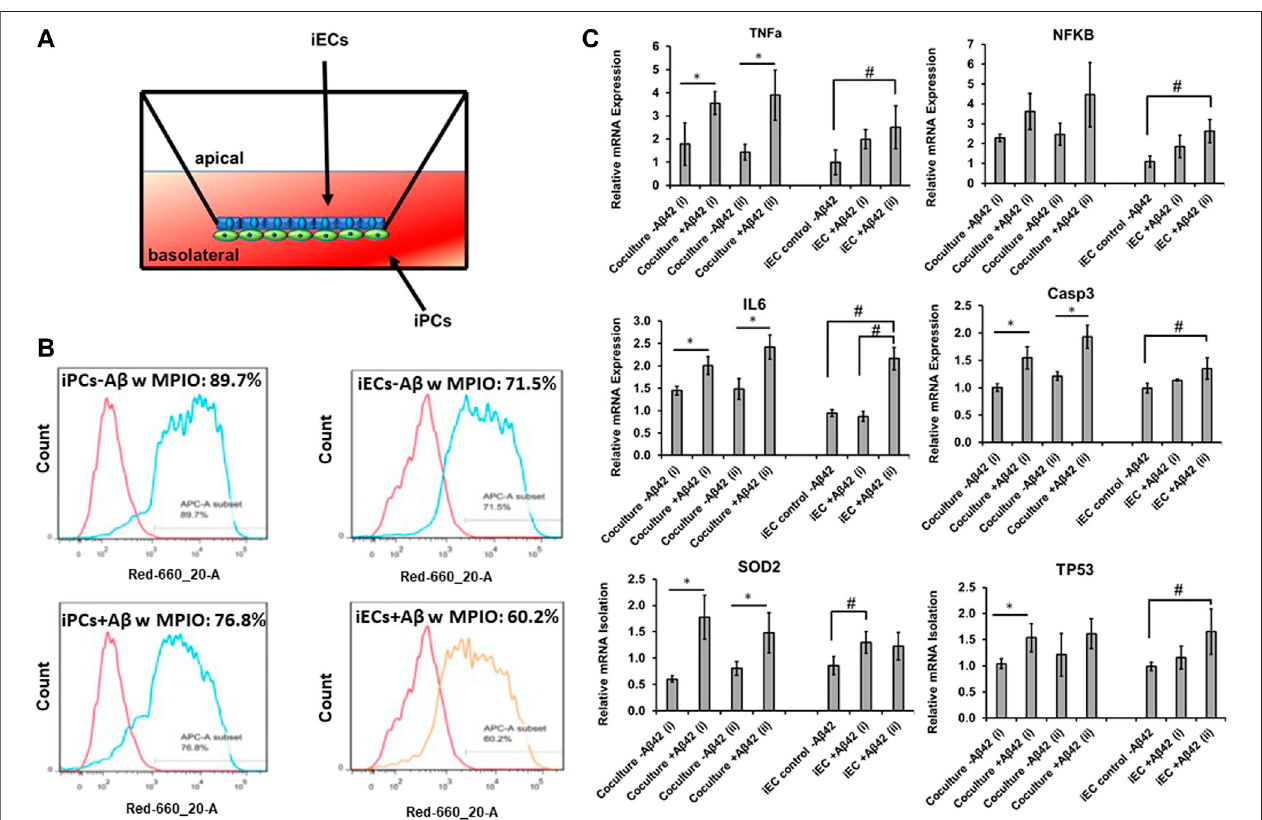
FIGURE 5 | mRNA levels of in fl ammatory response genes for A β 42 treated co-culture. (A) Illustration of the transwell of iEC and iPC co-culture. (B) Phagocytosis ability of the replated iPCs (day 25) and iECs determined by fl ow cytometry. The replated cells with or without A β 42 oligomer treatment (48 h) were exposed to MPIO at 5 μ gFe/mLfor24 h.TheMPIO+cells(Alexa647)wasquanti fi edby fl owcytometry.Tostudythein fl ammatoryresponse,thederivedendothelialcells(iECs)weretreated with A β 42 oligomers and compared to those without A β 42 treatment along with the transwell co-culture of iECs and iPCs with or without A β 42 oligomers. (C) RelativemRNAexpressionof TNFa , NFKB , IL6 , Casp3 , SOD2 ,and TP53 .ThemRNAexpressionwasnormalizedtotheA β 42negativegroupofiECs.N=3.TheRT-PCR results were expressed as the mean ± standard deviation. The t -test was used to compare the co-culture − /+A β 42 for run i and ii separately. * indicates p -value < 0.05fromthe t -test.One-wayANOVAfollowedbythe posthoc Tukey ’ stestwasusedtocomparethethreegroups:iECcontrol-A β 42,iEC+A β 42(i),andiEC+A β 42(ii). # indicates p -value < 0.05 from the Tukey ’ s